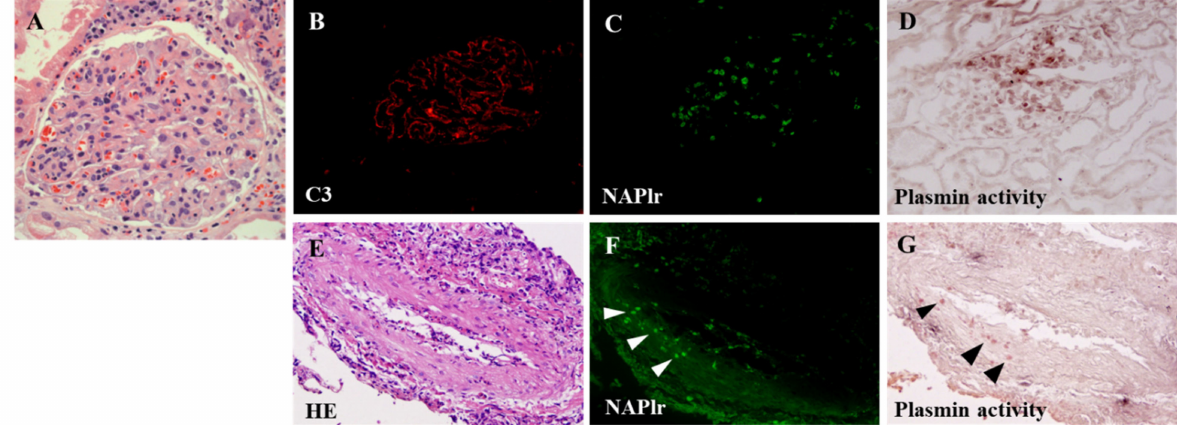
Figure 22. Kidney biopsy findings for case 8 in Table 8. ( A ): Light microscopy showing endocapillary proliferation with massive eosinophil infiltration (H&E, original magnification × 400). ( B ): Immunos- taining for C3. C3 was stained granularly along the glomerular tuft. NAPlr was positively stained in the glomeruli ( C ), and the distribution of plasmin activity ( D ) was similar to that of NAPlr staining in the glomeruli. ( E – G ): Eosinophils were observed to infiltrate in the wall of the pulmonary artery, where NAPlr positive immunostaining and strong plasmin activity were detected (arrowheads) in addition to in the glomerulus. Photographs are cited from a previously published report [84], where details of all the staining methods have been